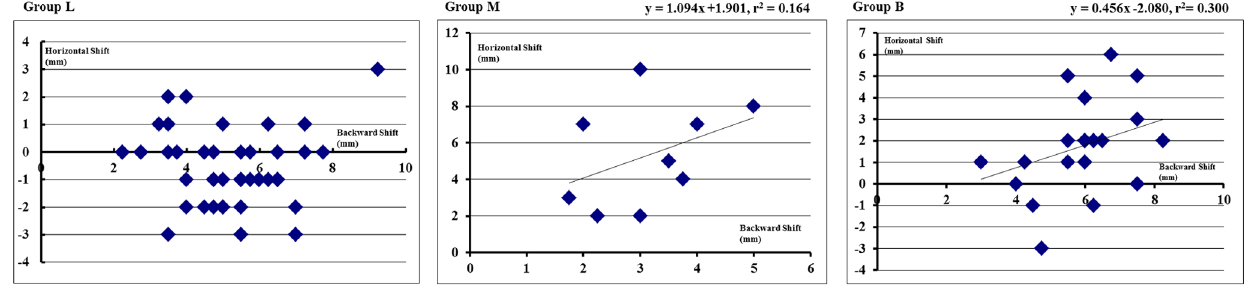
Figure 3. Scatter diagrams in each group with backward shift of the eyes on the x-axis and horizontal shift of the eyes on the